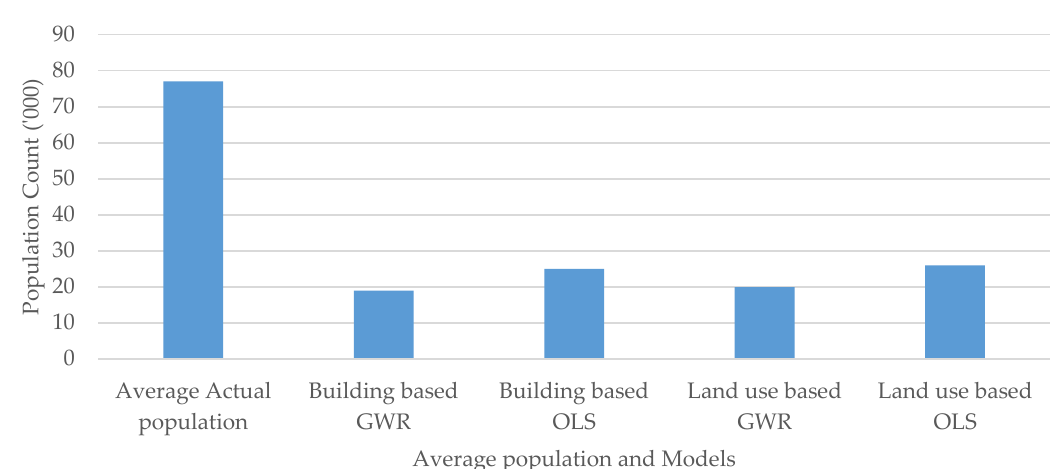
Figure 5. The figure shows the comparative analysis between the ward specific population count and the RMSE of each model, where the building based GWR model gives a better result than any other model. The result also gives an idea of how much the results differ from the actual average population.